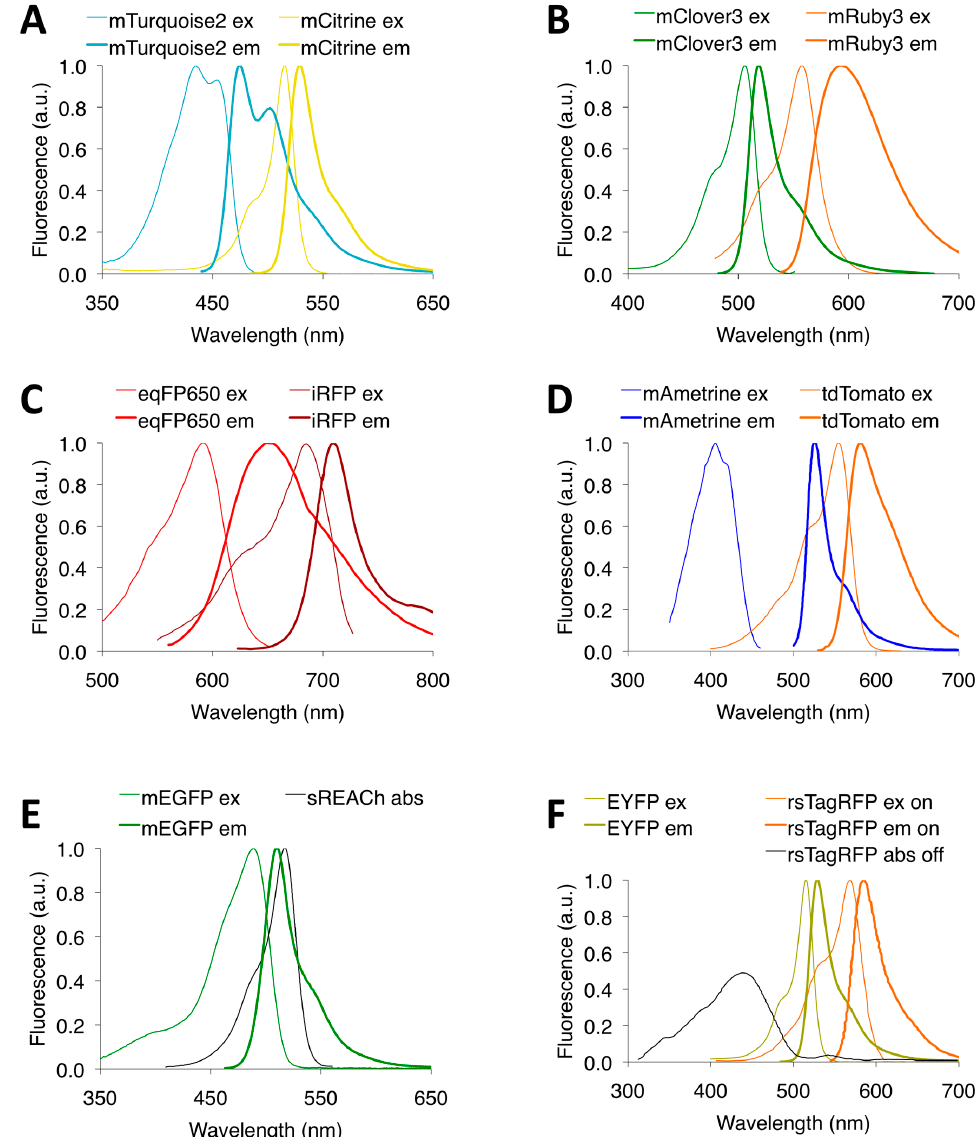
Figure 2. Normalized excitation (or absorbance) and emission spectra of FPs of representative two-color FRET pairs. ( A ) mTurquoise2-mCitrine, a CFP-YFP pair; ( B ) mClover3-mRuby3, a GFP-RFP pair; ( C ) eqFP650-iRFP, an FFP-IFP pair; ( D ) mAmetrine-tdTomato, a LSS-FP based pair; ( E ) mEGFP-sREACh, a dark FP-based pair; ( F ) EYFP-rsTagRFP, an optical highlighter FP-based pair.